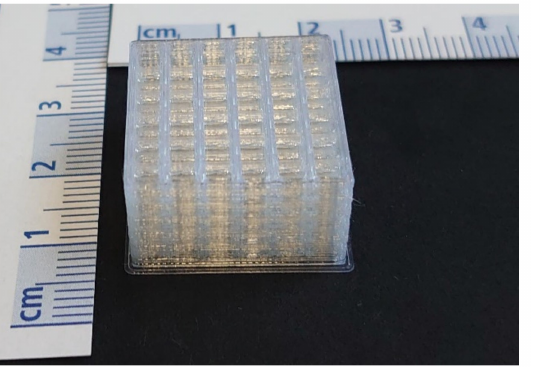
Figure A1. Exemplary Image of inversely 3D printed sacrificial structure which represents the pore structure within the final